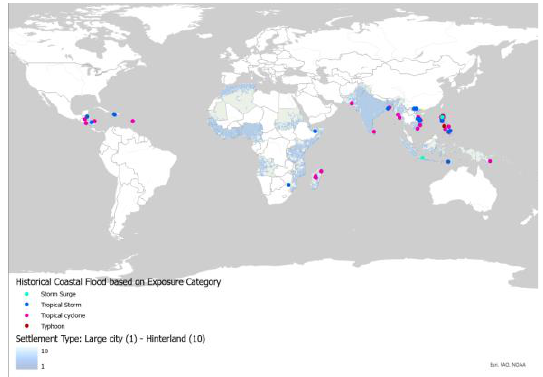
Figure 3. Global distribution of historical coastal floods (2006-